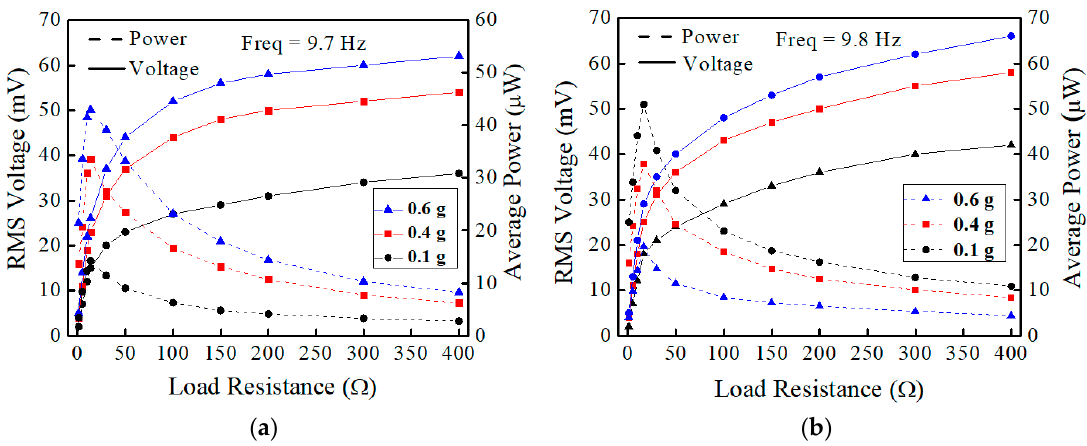
Figure 8. ( a ) Dependence of load voltage and power of the coil-I on the external load resistance at resonance (9.7 Hz), under 0.1g 0.4 g and 0.6 g. ( b ) Load voltage and power as a function of various load resistances across coil-II, under 0.1g 0.4 g and 0.6 g at 9.7 Hz.